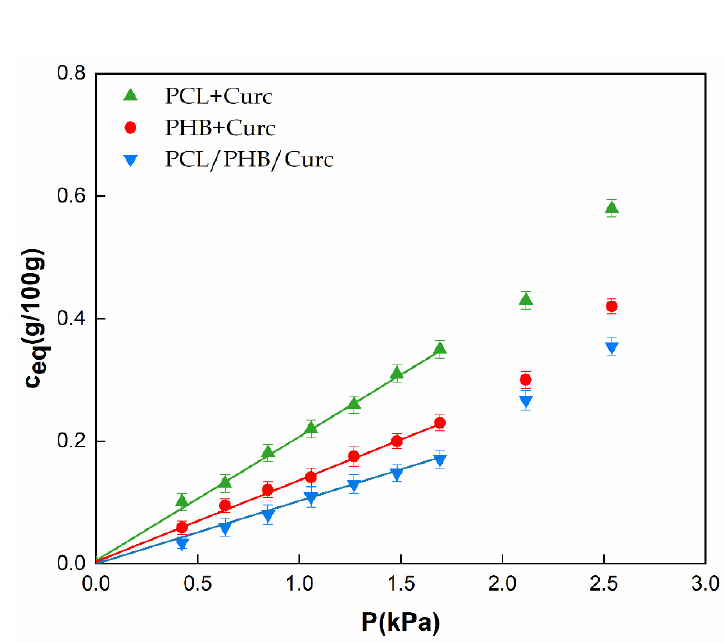
Figure 8. Sorption isotherms for electrospun membranes.